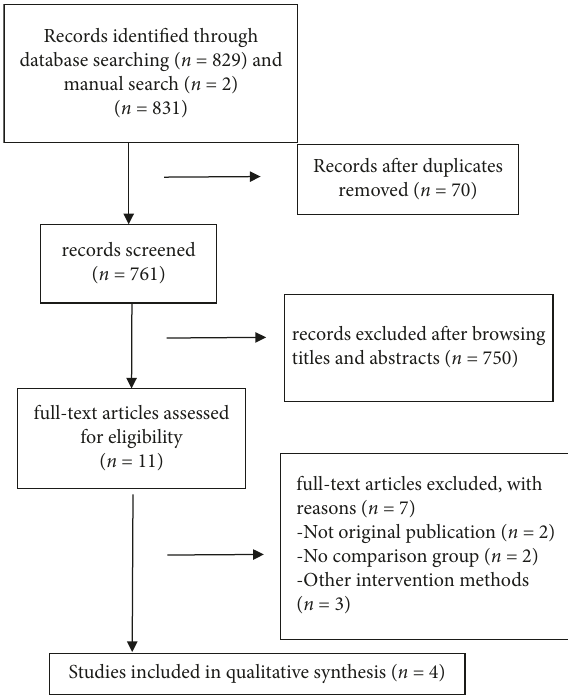
Figure 1: Study selection